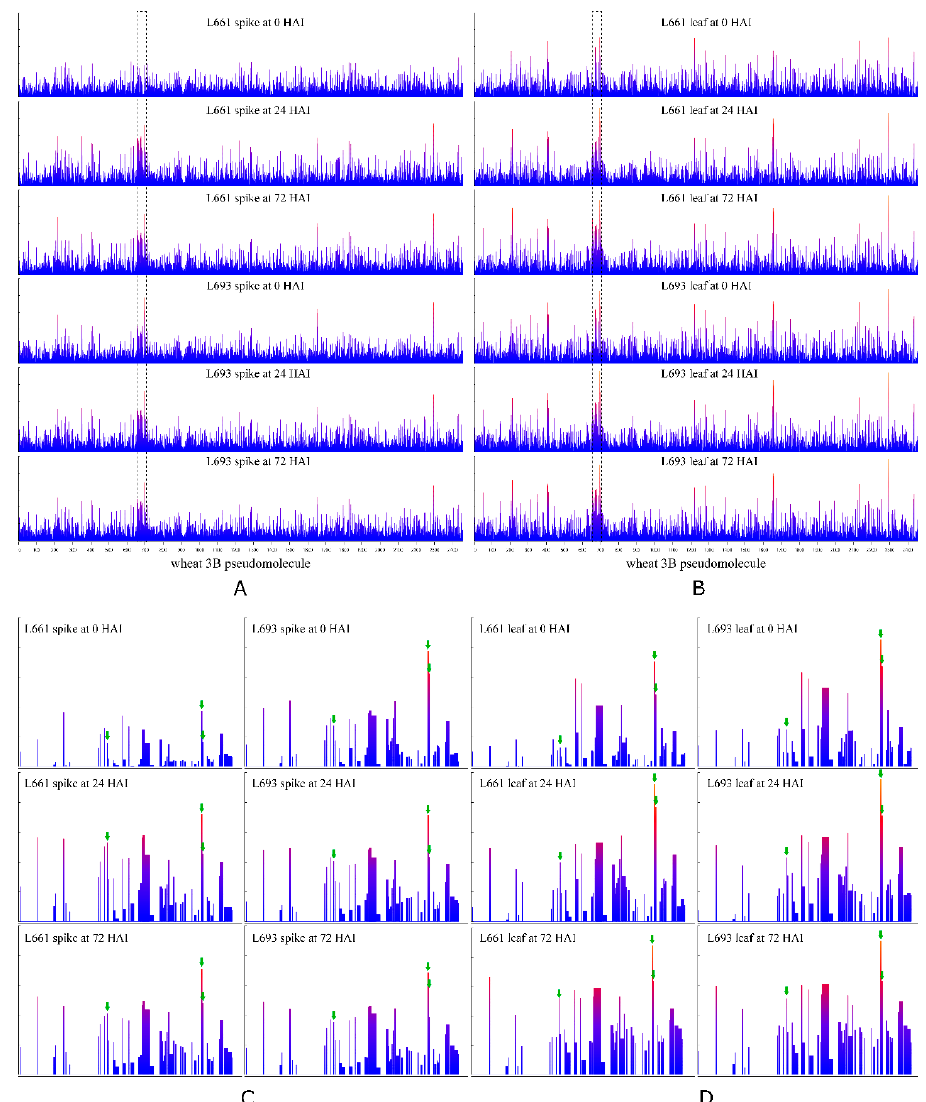
Figure 7. Distribution of gene expression levels on chromosome 3B in all 12 samples. The x -axis represents the chromosome range 0–774.43 Mb. The y -axis represents the normalized log (RPKM+1) range 0–1. The region included in the dashed rectangle indicates the 181.40–181.54 Mb region. Distribution of gene expression level on chromosome 3B for six spike samples ( A ) and six leaf samples ( B ). Distribution of gene expression level in the gene island at region 181.40–181.54 Mb of chromosome 3B for six spike samples ( C ) and six leaf samples ( D